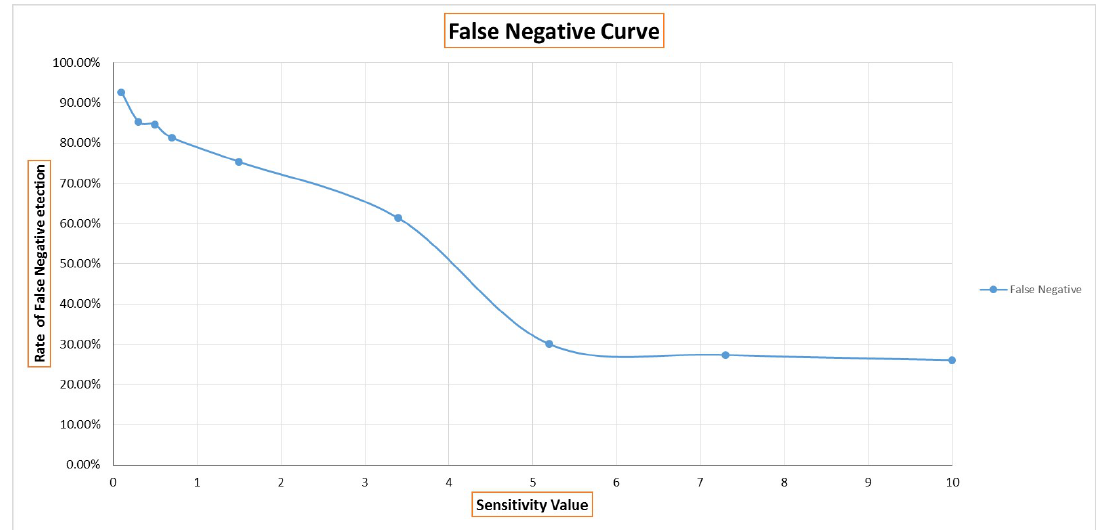
Figure 9. Overall false negative rate of google image database (SAFE ON) with different sensitivity